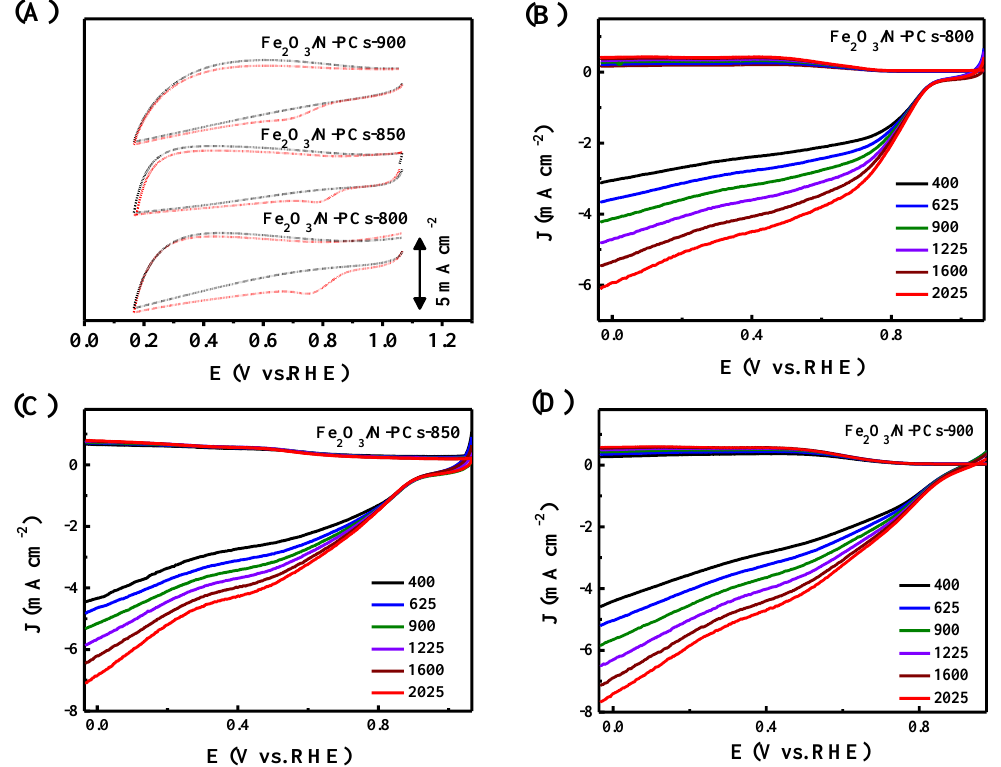
Figure 6. Cyclic voltammograms of Fe 2 O 3 /N-PCs-800, Fe 2 O 3 /N-PCs-850 and Fe 2 O 3 /N-PCs-900 ( A ) modified GC electrodes in O 2 - and in N 2 -saturated 0.1 M KOH at a scan rate of 10 mV·s −1 . LSV curves of Fe 2 O 3 /N-PCs-800 ( B ), Fe 2 O 3 /N-PCs-850 ( C ) and Fe 2 O 3 /N-PCs-900 ( D ) on RRDE at a scan rate of 5 mV·s −1 with various rotation rates.